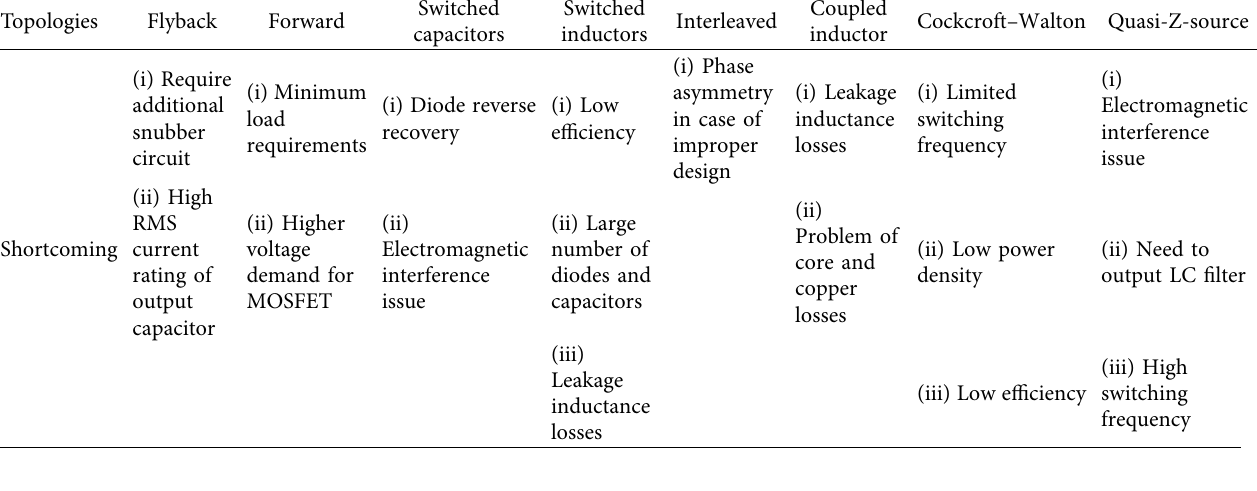
Table 1: Shortcomings of voltage boosting techniques.